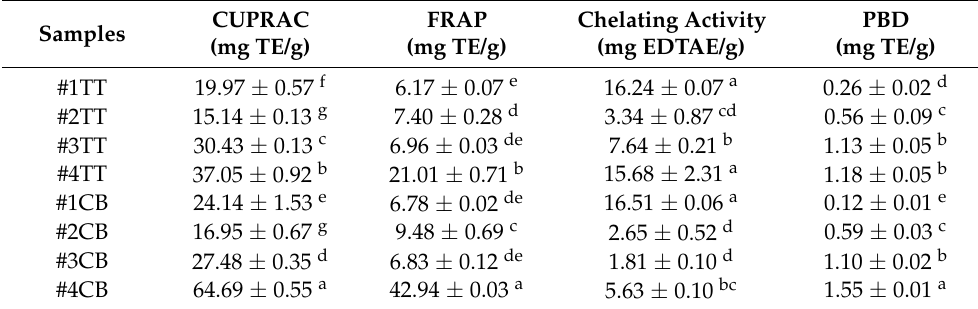
Table 3. Antioxidant activity of the tested